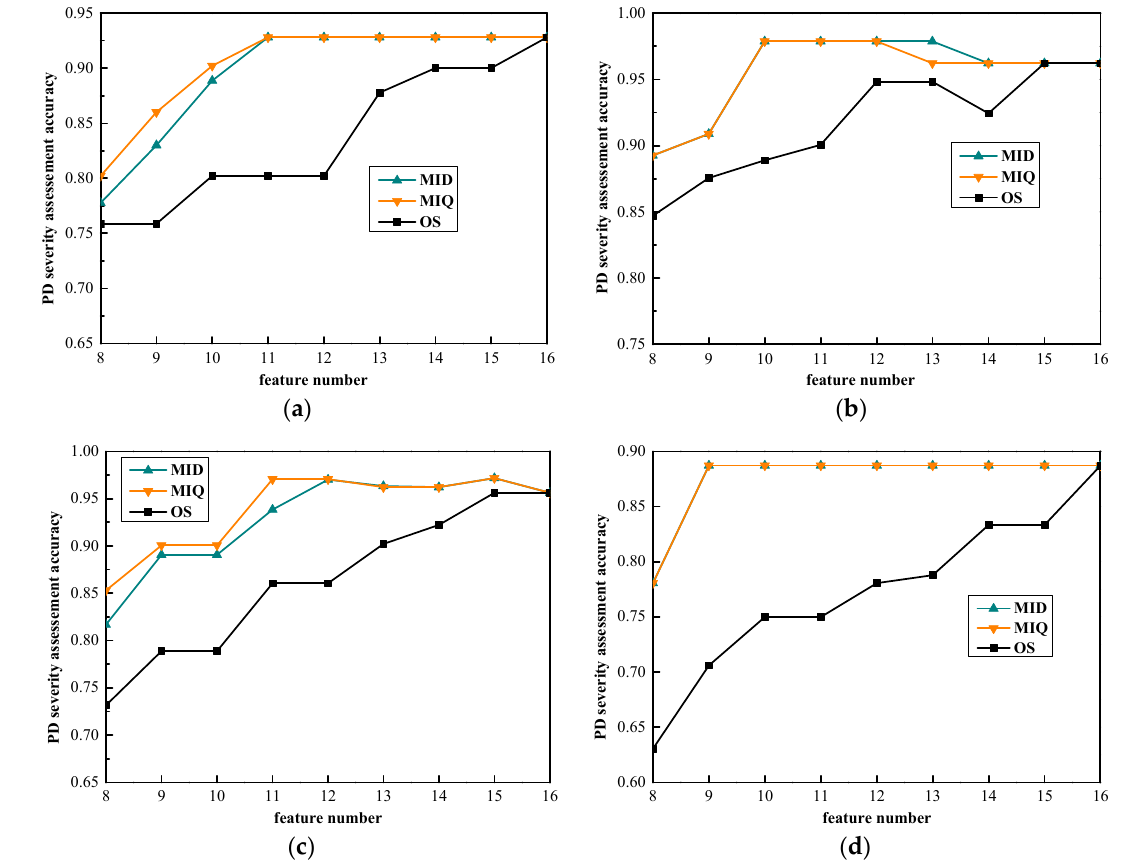
Figure 4. The PD severity assessment accuracy of four defects in the three types of feature sorting. ( a )